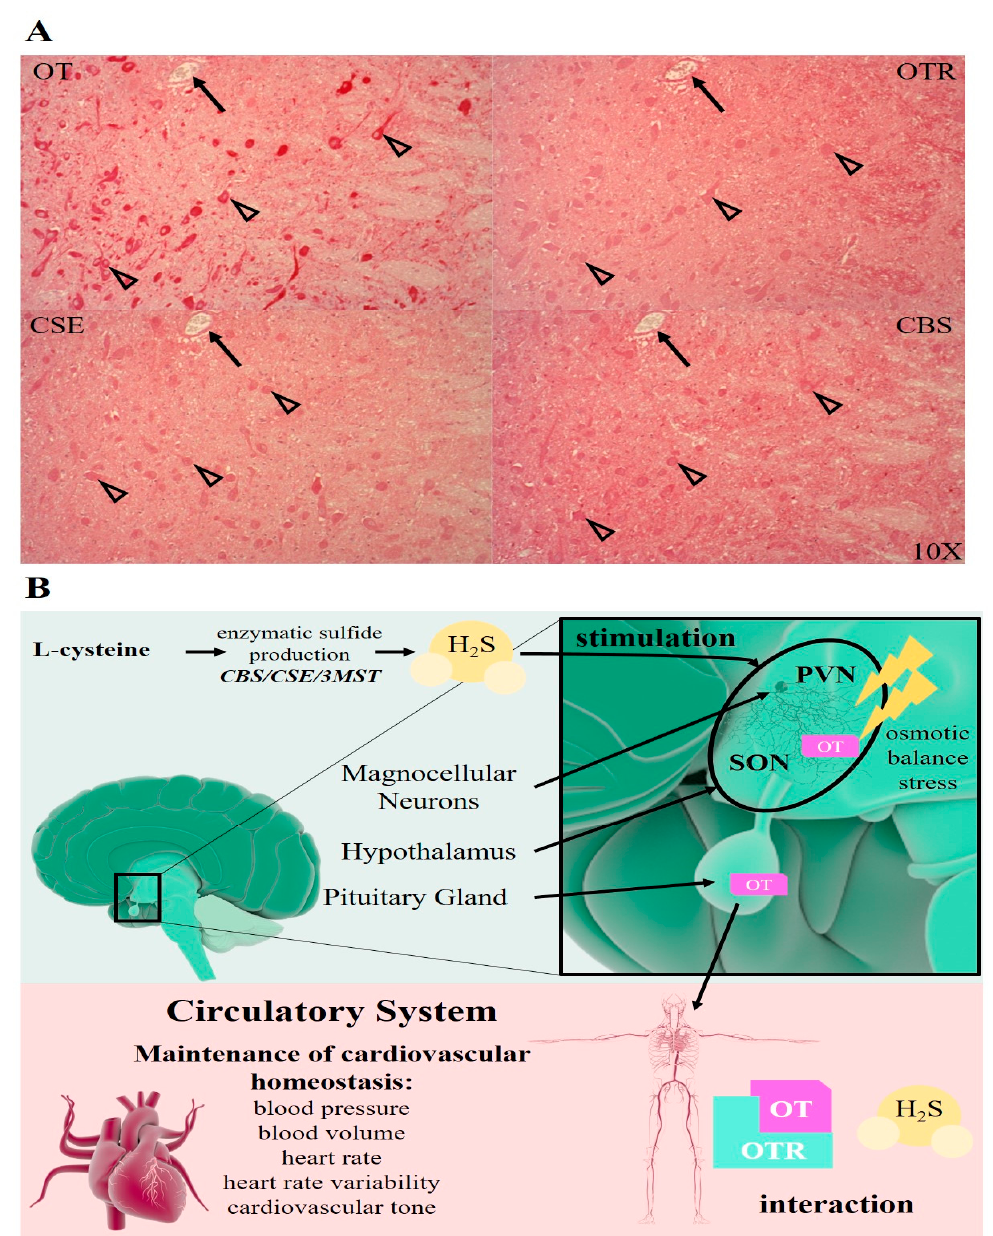
Figure 2. H 2 S can stimulate hypothalamic OT release. ( A ): OT, OTR, CSE and CBS co-localize (in red) in the magnocellular neurons (open arrow heads) of the porcine hypothalamus. Black arrows are pointing to the same blood vessel in consecutive brain sections of the porcine hypothalamus (10 × ). Brain sections were obtained from an atherosclerotic pig model of resuscitated